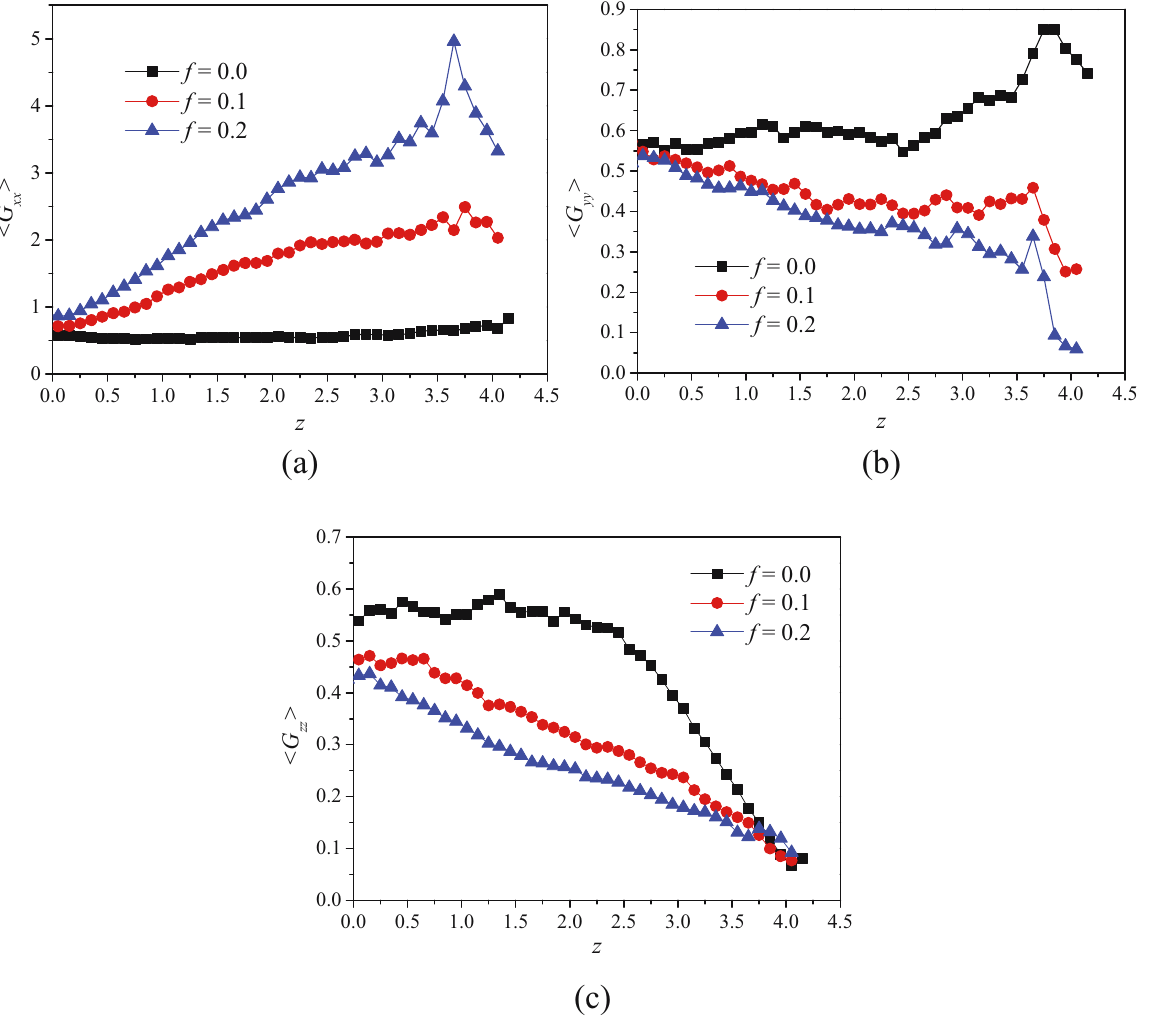
Figure 7: Distribution of the three diagonal elements of the gyration tensor across the slit for the driving force f = 0, 0.1, and 0.2: ( a ) 〈 G xx 〉 , ( b ) 〈 G yy 〉 , and ( c ) 〈 G zz 〉